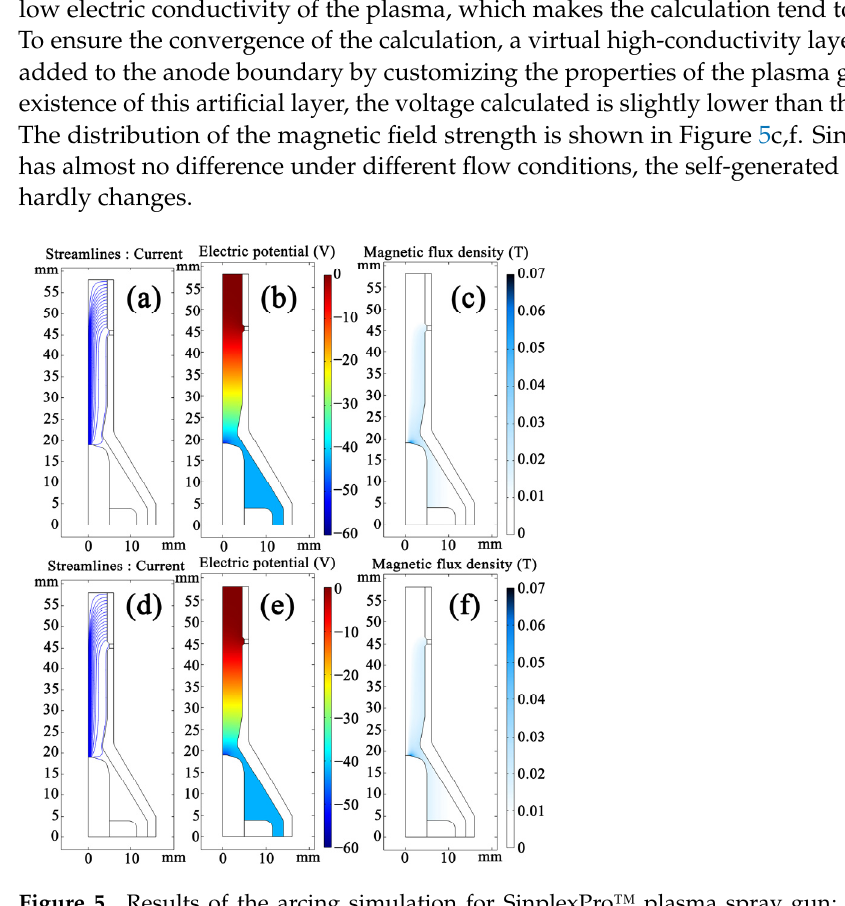
Figure 5. Results of the arcing simulation for SinplexPro™ plasma spray gun; laminar model: ( a ) electric potential distribution, ( b ) magnetic field strength distribution, and ( c ) current streamline; turbulent model: ( d ) electric potential distribution, ( e ) magnetic field strength distribution, and ( f ) current streamline.